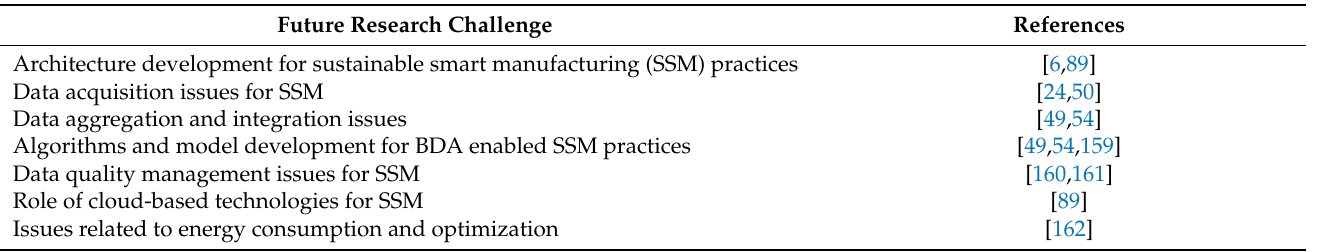
Table 6. Research issues in big data analytics in Industry 4.0 for manufacturing sustainability.